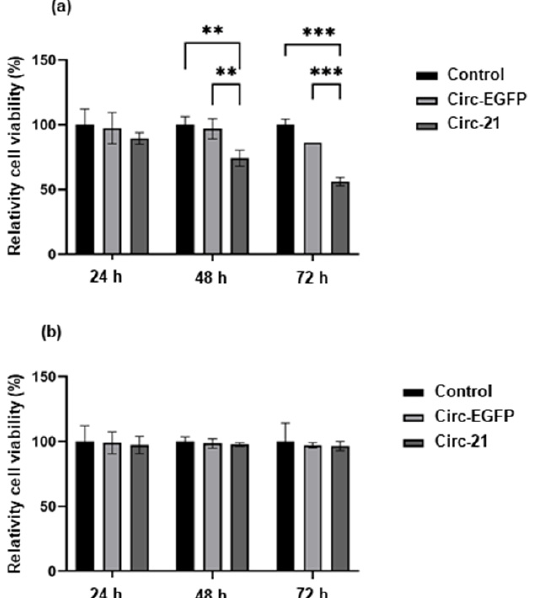
Figure 3. Effect of the Circ-21 on cell growth. MCF7 ( a ) and MCF10A ( b ) were transfected with the Circ-21 and the Circ-EGFP to determine proliferation rate modulation after 24, 48 and 72 h after transfection. The Circ-21 induced a time-dependent decrease in the MCF7 cell growth that was not observed when they were transfected with the Circ-EGFP or in the control cells Values represent means ± SD. ( n = 3); ** p < 0.01 and *** p < 0.001.